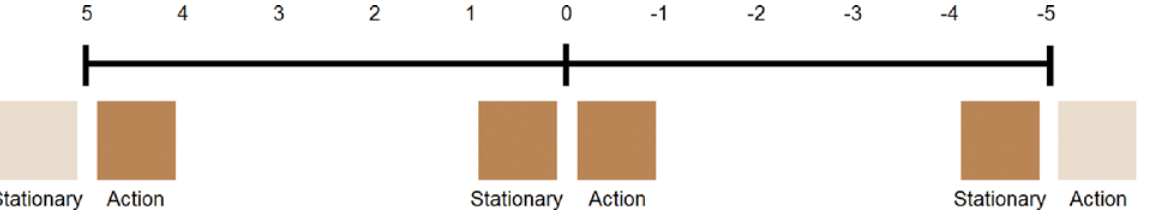
Fig 4. Relative vividness measure. Participants rate the vividness of the action block's afterimage relative to the vividness of the stationary block's afterimage, on an 11-point scale ranging from -5 (much less vivid) to +5 (much more vivid). Adapted from Hogendoorn et al.